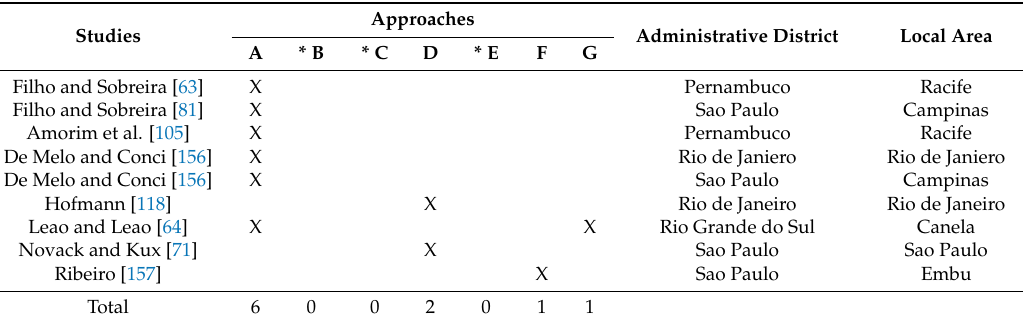
Table 3. Studies of slums in Brazil using H/VH-R resolution, classified by analysis approach. (A) Multi-scale analysis; (B) Image texture analysis; (C) Landscape analysis; (D) Object-based image analysis; (E) Building feature extraction; (F) Data mining and (G) Remote sensing data for supporting socio-economic